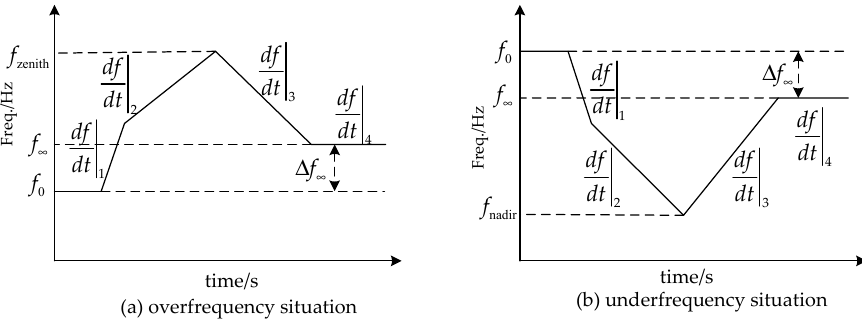
Figure 12. Frequency dynamic response curve describing inertia support and primary frequency regulation capability: ( a ) in the overfrequency situation; ( b ) in the underfrequency situation.